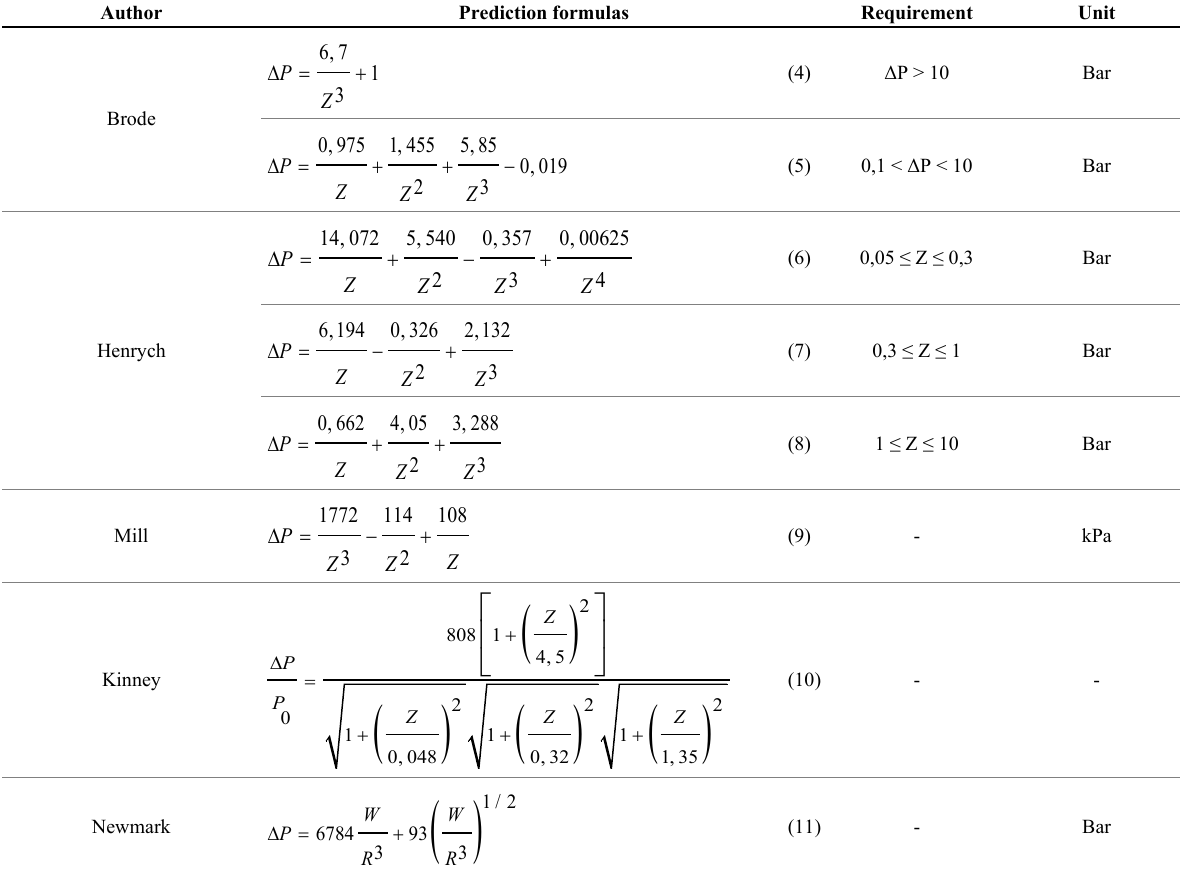
Were Z = scaled distance (m/kg 1/3 ); R = distance from explosion center to analysis point (m); and W = TNT mass (kg). The overpressures can be predicted with the semi-empirical models shown in Table 1, that are valid for open-air explosions from spherical explosive charges. Table 1. Semi- empirical overpressure (ΔP) prediction equations [